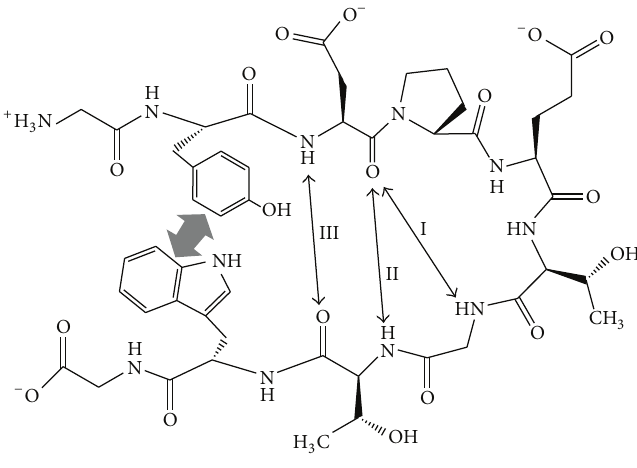
Figure 2: Structure of chignolin. Three native hydrogen bonds (H-bonds I, II, and III) and a hydrophobic interaction between Tyr2 and Trp9 are indicated by arrows